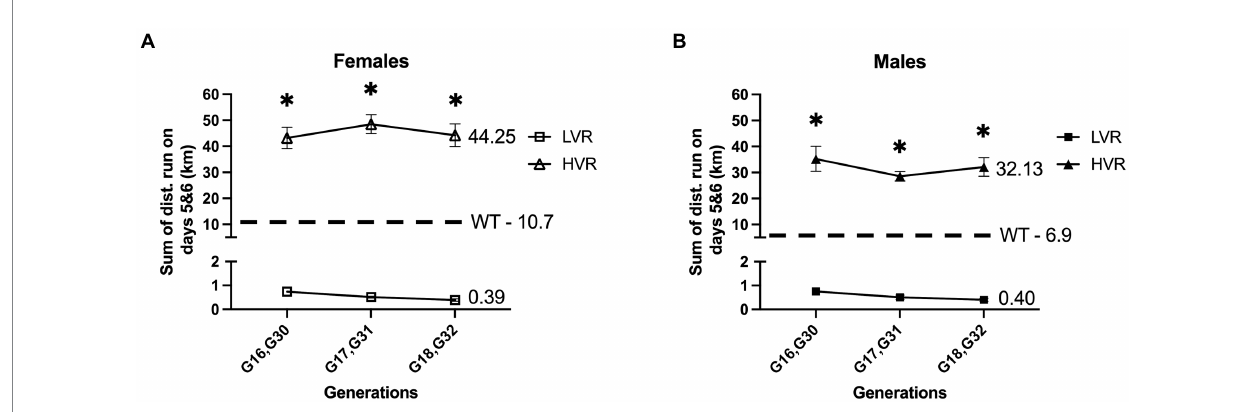
FIGURE 1 Generational wheel running distances for LVR and HVR relative to representative WT values. (A) Running distances on days 5 and 6 for female LVR generations 16–18 (G16-18) and HVR generations 30–32 (G30-32) with female WT Wistar rats serving as a reference point. (B) Running distances on days 5 and 6 for male LVR generations 16–18 (G16-18) and HVR generations 30–32 (G30-32) with male WT Wistar rats serving as a reference point. * Denotes significant post-hoc difference relative to LVR following two-way